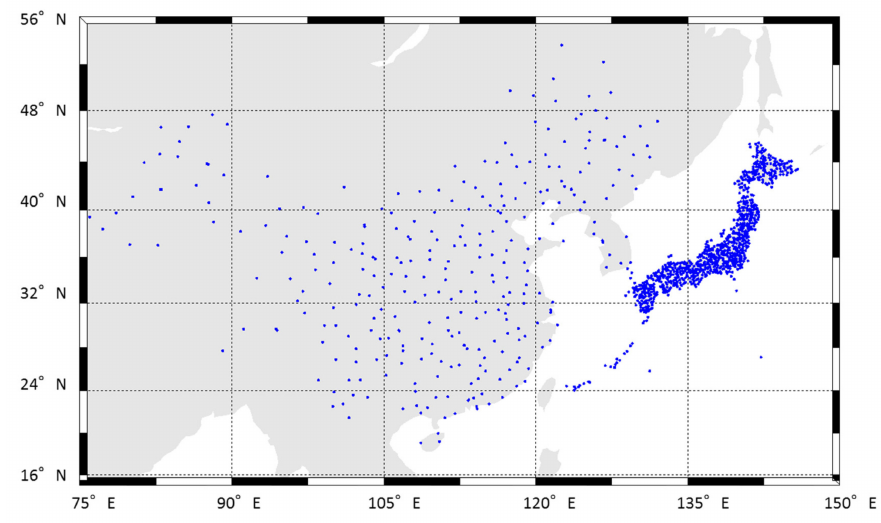
Figure 3. Position of weather